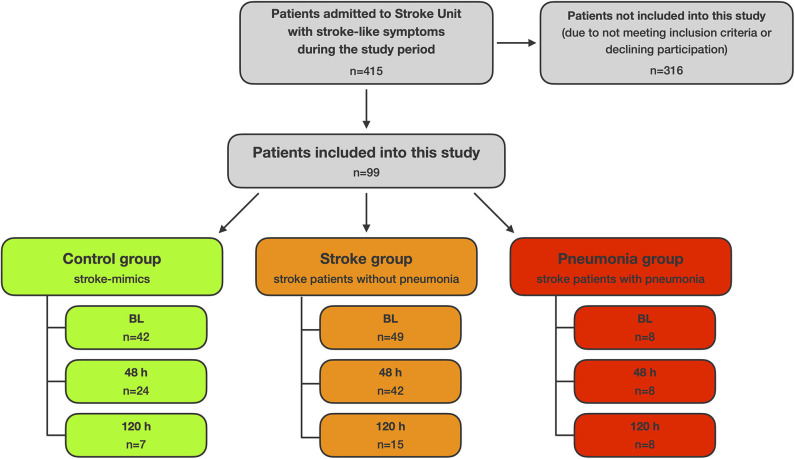
Flow of patients.